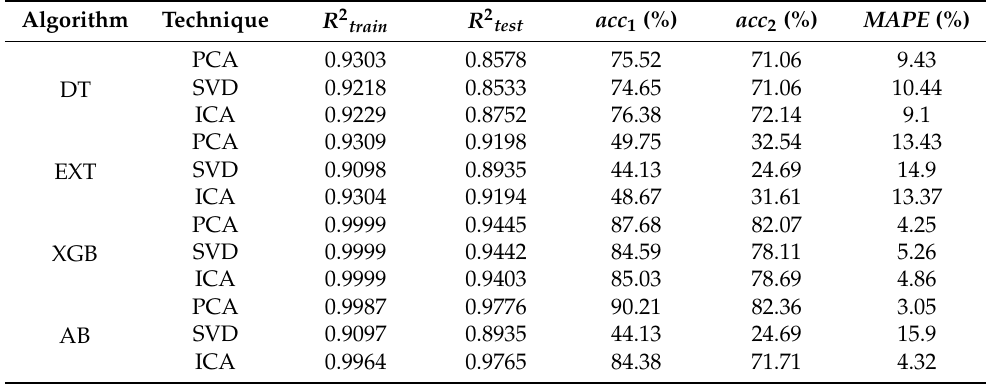
Table 6. Data bias